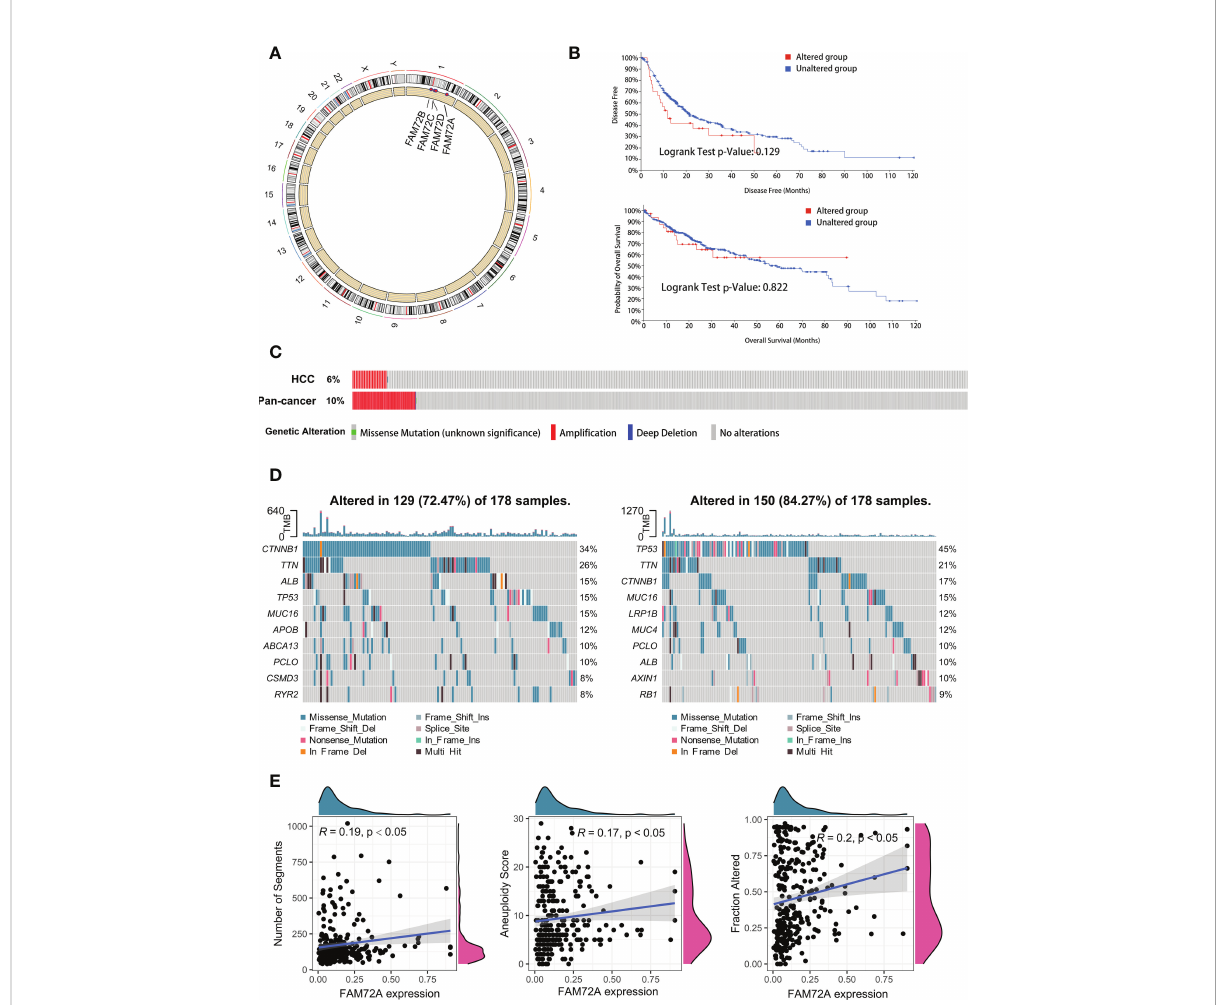
FIGURE 5 Landscape of genomic alterations and mutation pro fi les in HCC. (A) Chromosomal localization and genetic alterations in FAM72A family genes. (B) The cBioPortal database provides the difference in survival, regardless of the presence of FAM72A alterations. Statistical analyses were performed using the log-rank test. (C) The cBioPortal database provides the genomic alterations in FAM72A in HCC and pancancer. (D) Changes in the somatic mutation frequency between the high (right panel) and low (left panel) FAM72A expression groups. (E) Correlation between FAM72A mRNA expression and distinct mutation indices (number of segments, aneuploidy score, and fraction altered). Statistical analyses were performed using the Spearman correlation